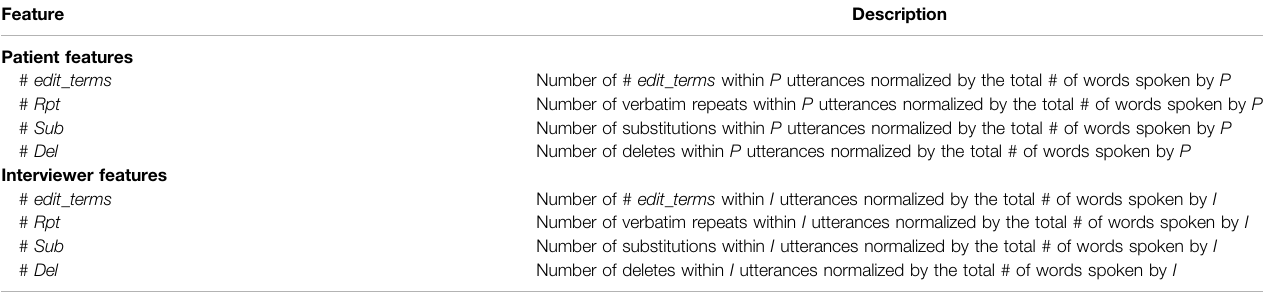
TABLE 2 | The proposed dis fl uency feature set.